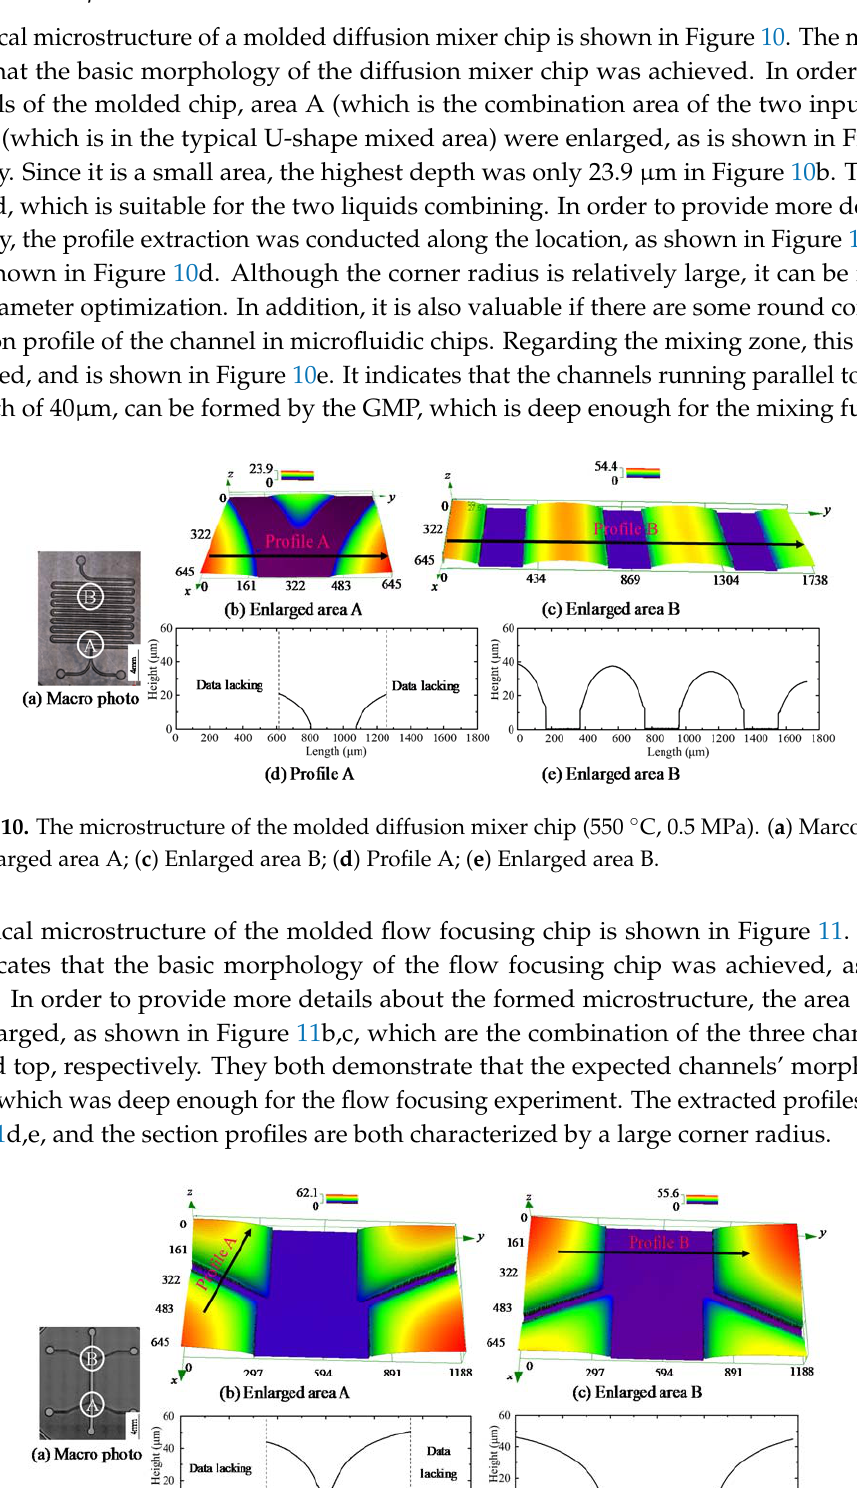
Figure 11. The microstructure of the molded flow focusing chip (550 °C, 0.5 MPa). ( a ) Macro photo; ( b ) Enlarged area A; ( c ) Enlarged area B; ( d ) Profile A; ( e ) Profile B.